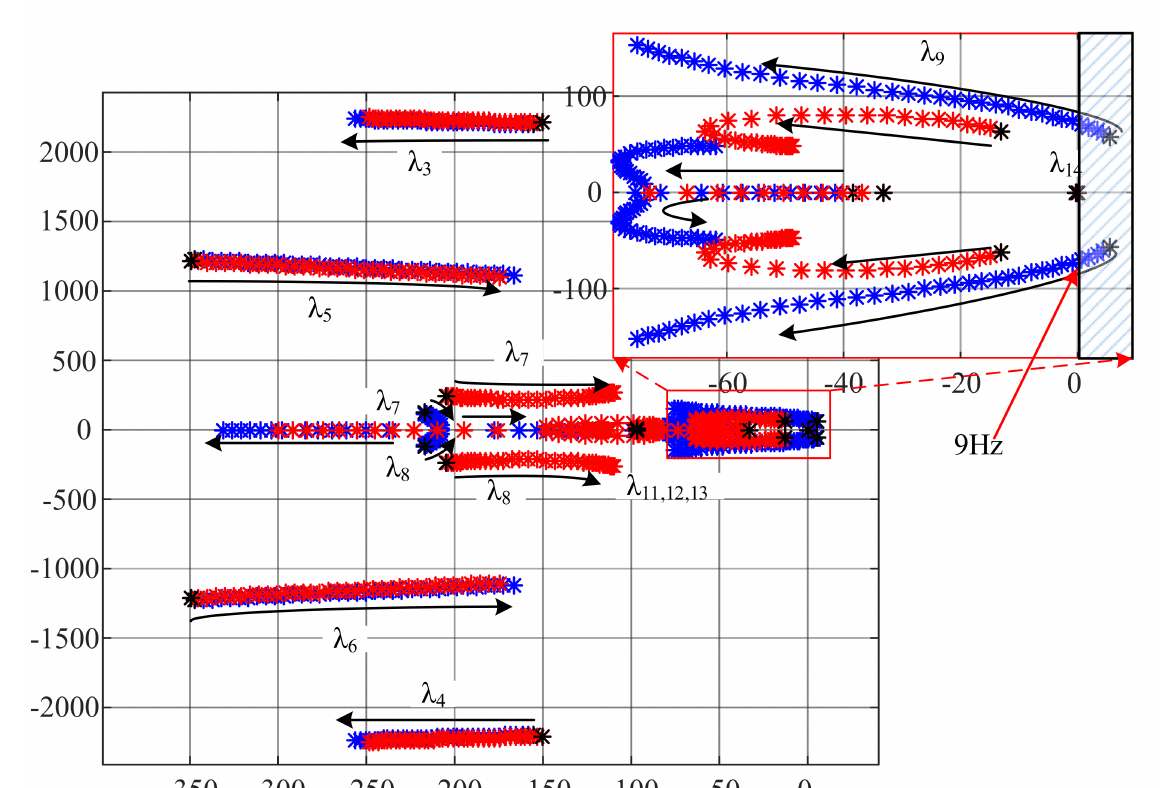
Figure 9. Sensitivity of system eigenvalues under variation of AVC control